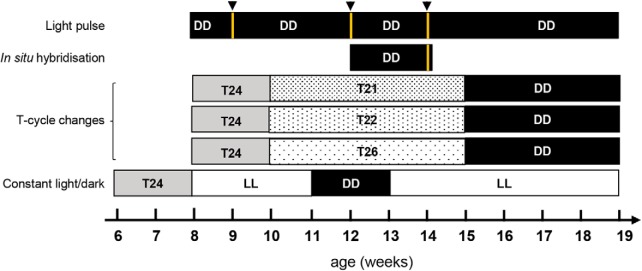
Experimental outline and light schedule for testing. The diagram shows the different light/dark settings for the light pulse, in situ hybridization, T-cycle changes (with T24 corresponding to 12 LD cycle; T21 to 10.5 LD cycle; T22 to 11 LD cycle and T26 to 13 LD cycle) and constant light (LL)/dark (DD) experiments. Black arrowheads and yellow lines show the age at which the 15 min light pulse was administered.